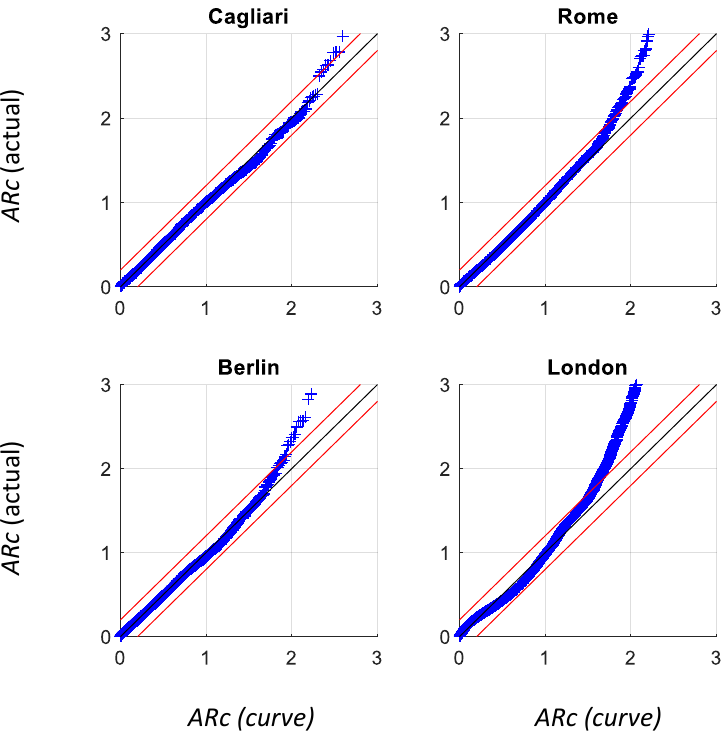
Figure 11. Q-Q plots for ARc ; actual data on the Y -axis, best-fit curves on the X -axis; the black line is the bisector, the two red straight lines highlighting a tolerance interval.